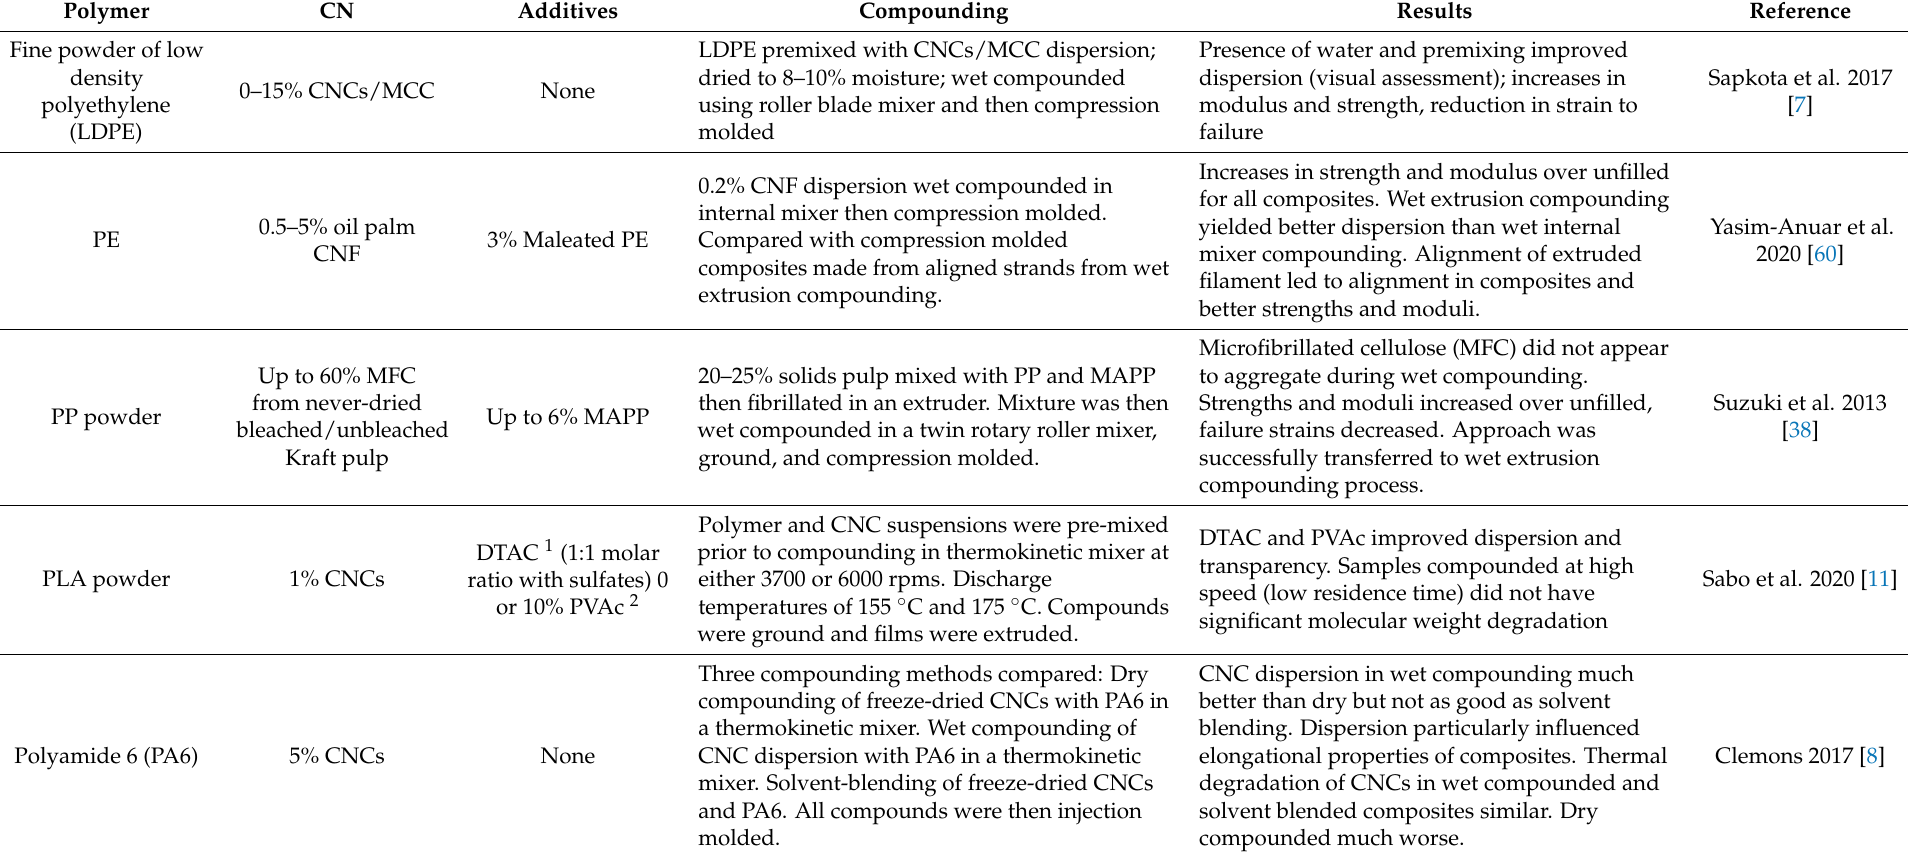
Table 5. Cellulose nanocomposites produced by via wet batch